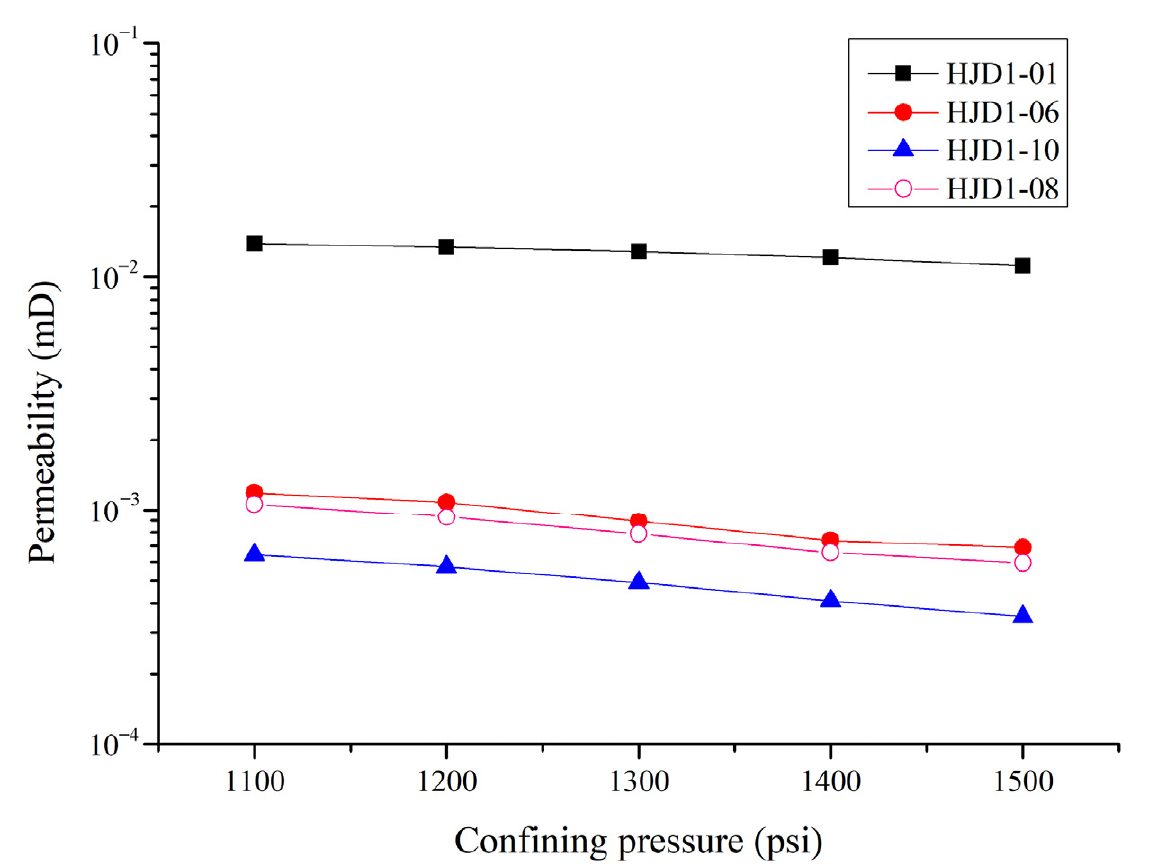
Figure 4. Relationship between confining pressure and permeability.